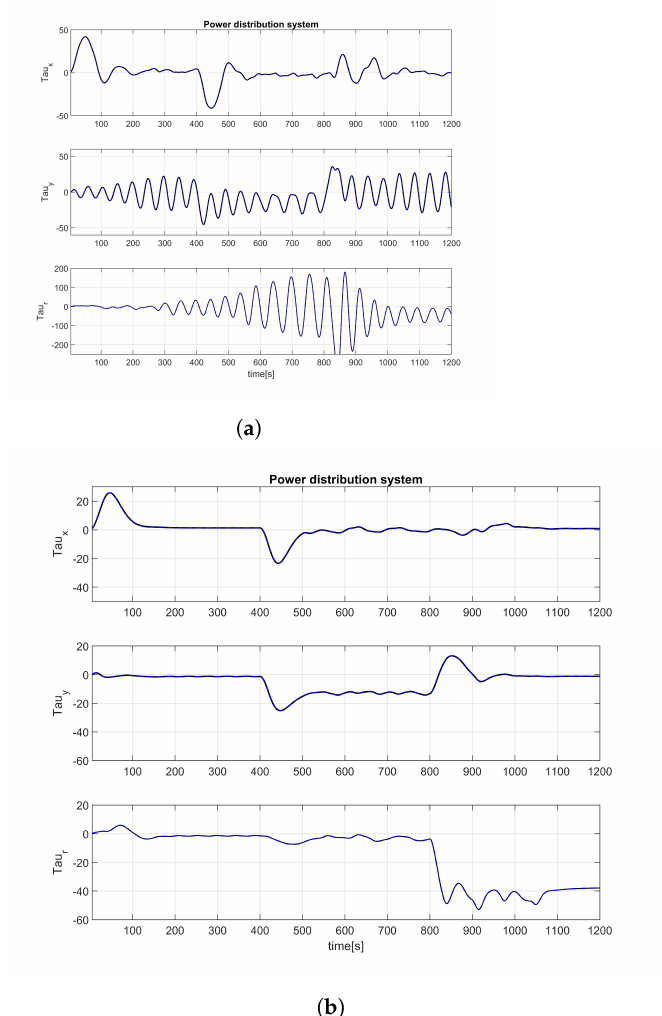
Figure 7. Controlled object has three input signals: τ x ; τ y ; τ r , where: [ τ x ] - required force (thrust) on the ships longitudinal axis, [ τ y ] - required force (thrust) on the ships lateral axis, [ τ r ] - required rotational force. ( a ) γ ∞ = 1.1, ( b ) γ ∞ =